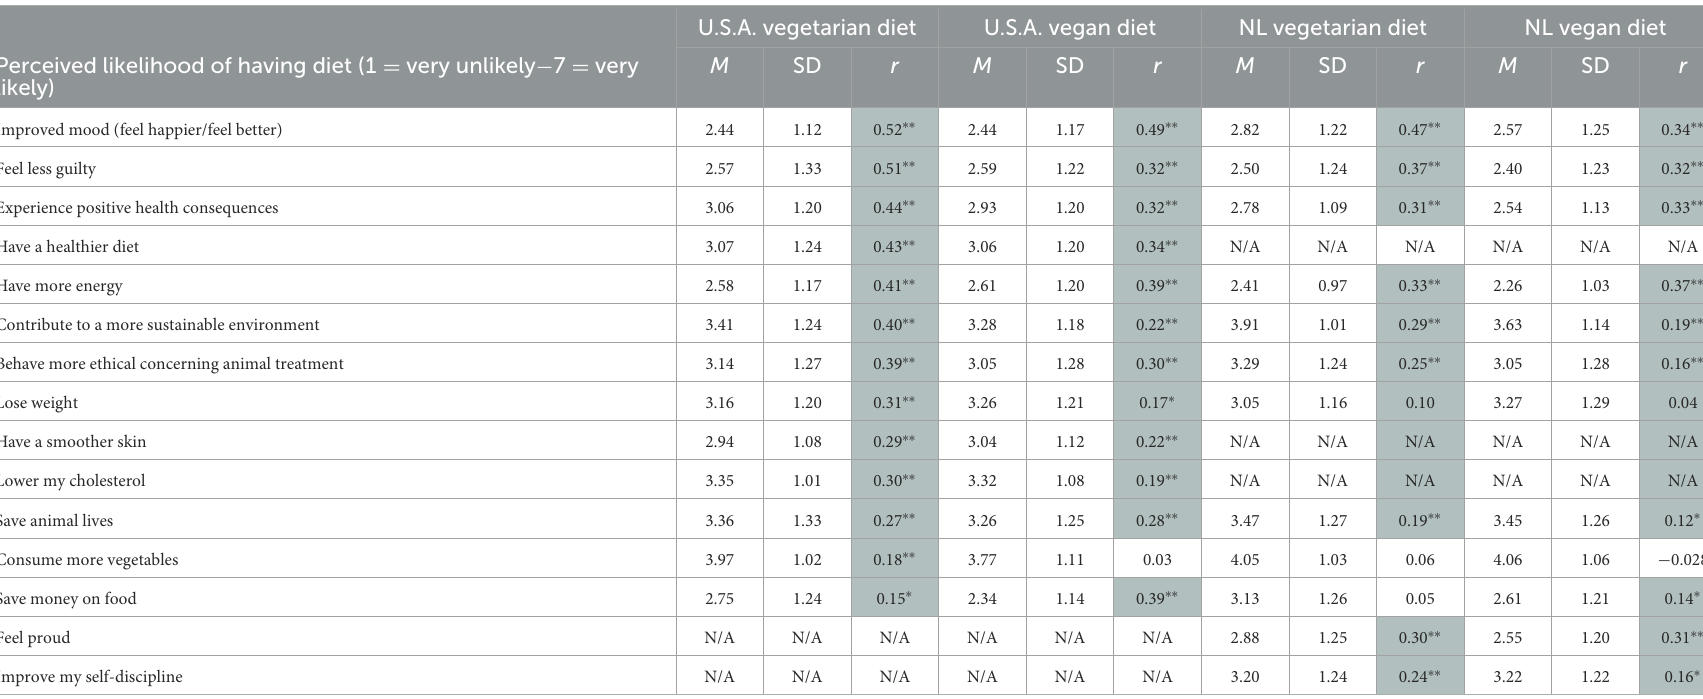
TABLE 7A Positive attitudinal beliefs about having a vegetarian and having a vegan diet: means (M), standard deviations (SD), and correlation (r) with behavioral